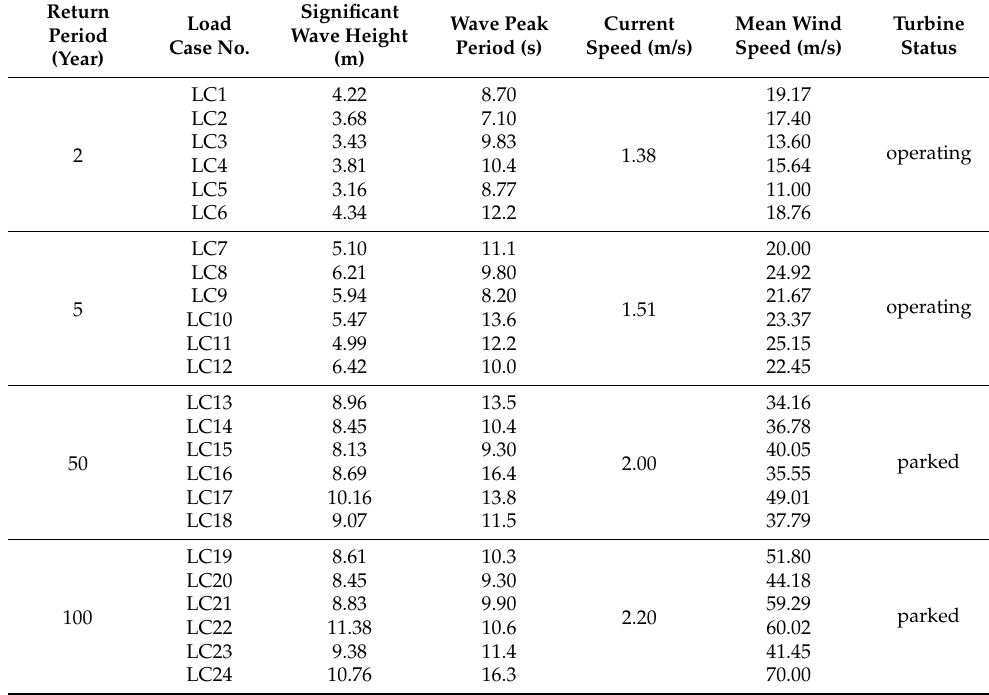
Table 6. The parameters of wind-wave combined dynamic load cases.